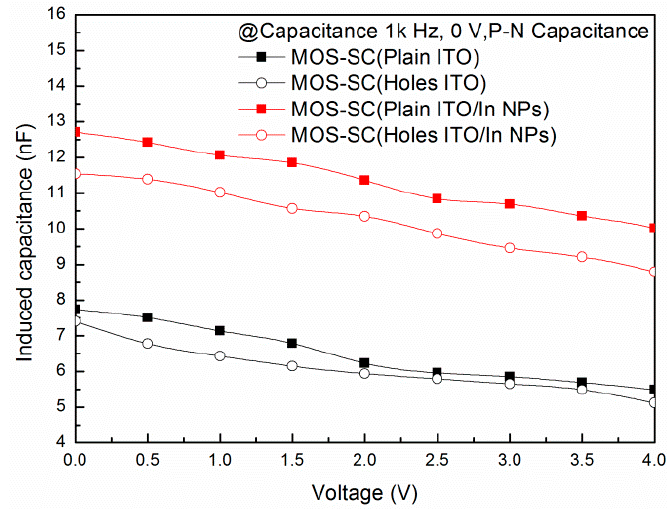
Figure 5. Induced capacitance of all MOS cells: measurements obtained at the front Al/Ti electrode and back Al electrode are a function of voltage applied to the ITO electrode.